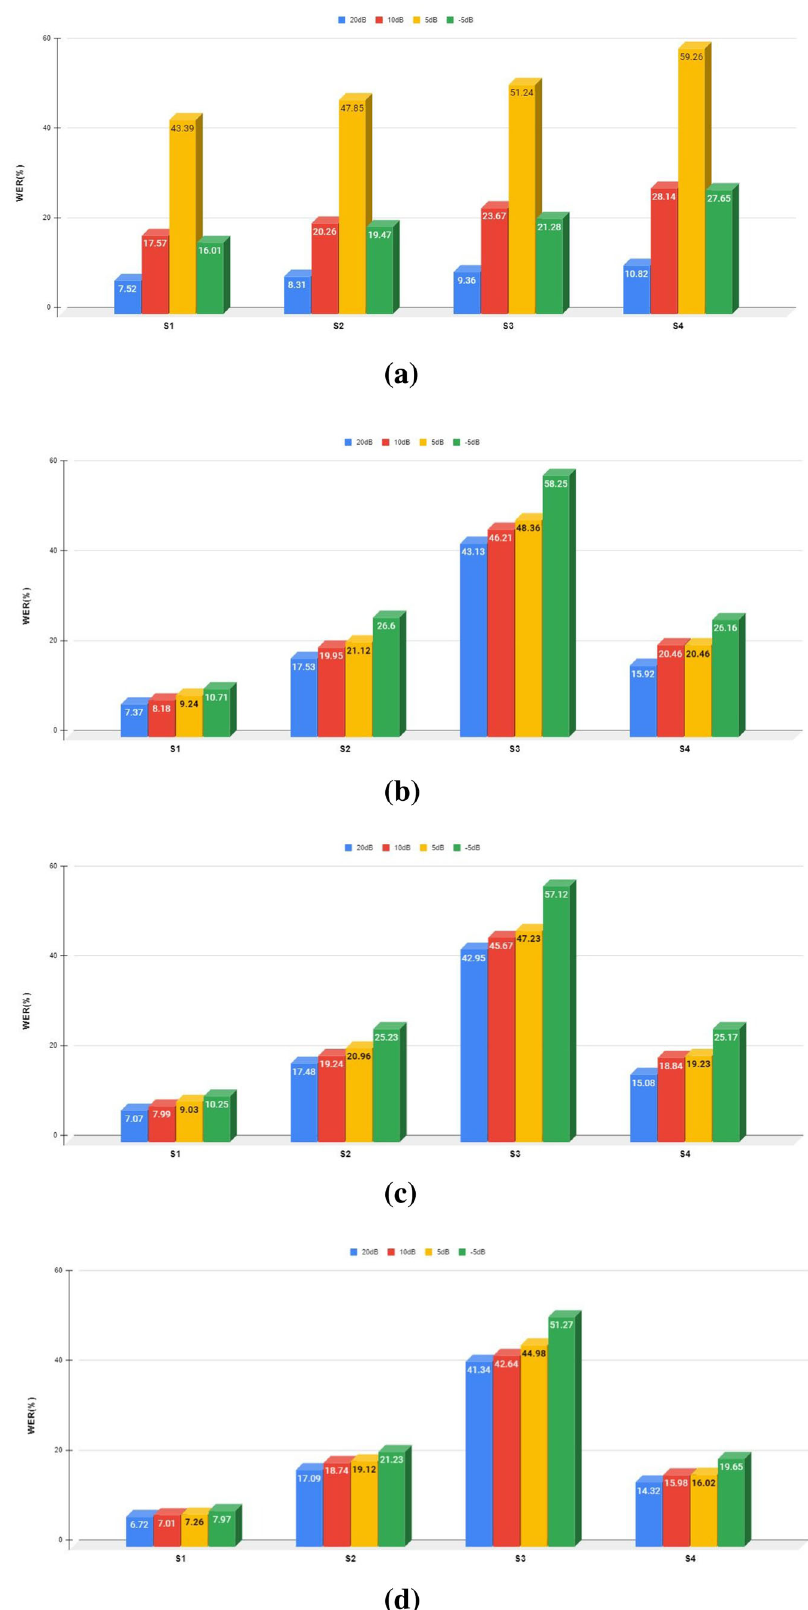
Fig. 7 a WER obtained on utilization of MFCC feature extraction technique on both matched and mismatched systems. b WER obtained on utilization of RASTA-PLP feature extraction technique on both matched and mismatched systems. c WER obtained on utilization of GFCC feature extraction technique on both matched and mismatched systems. d WER obtained on utilization of PNCC feature extraction technique on both matched and mismatched